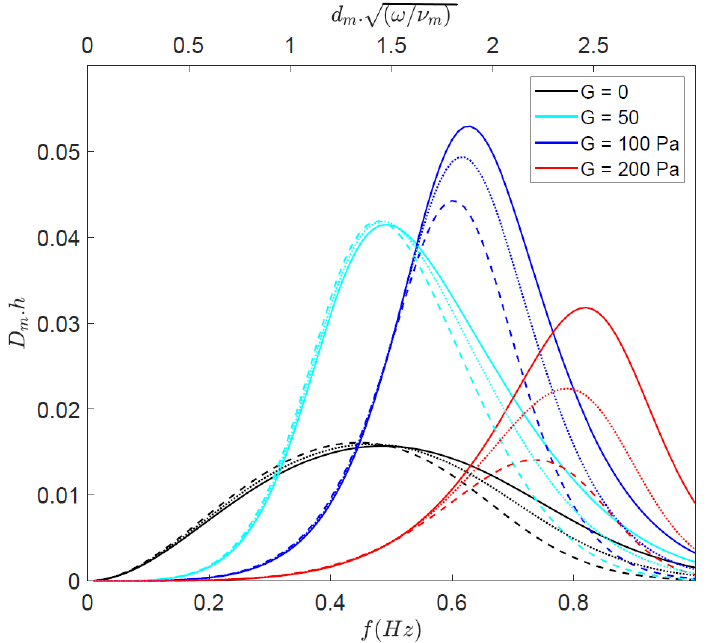
Figure 3. Surface wave damping rate as a function of frequency for different shear moduli of mud in the presence of co-propagating current with U = + 0.15 m/s (solid line), without current (dot line), and in the presence of counter-propagating current with U = − 0.15 m/s (dashed line), ζ = 100, h = 1.00 m, d m = 0.12 m, and ρ m = 1111 kg/m 3